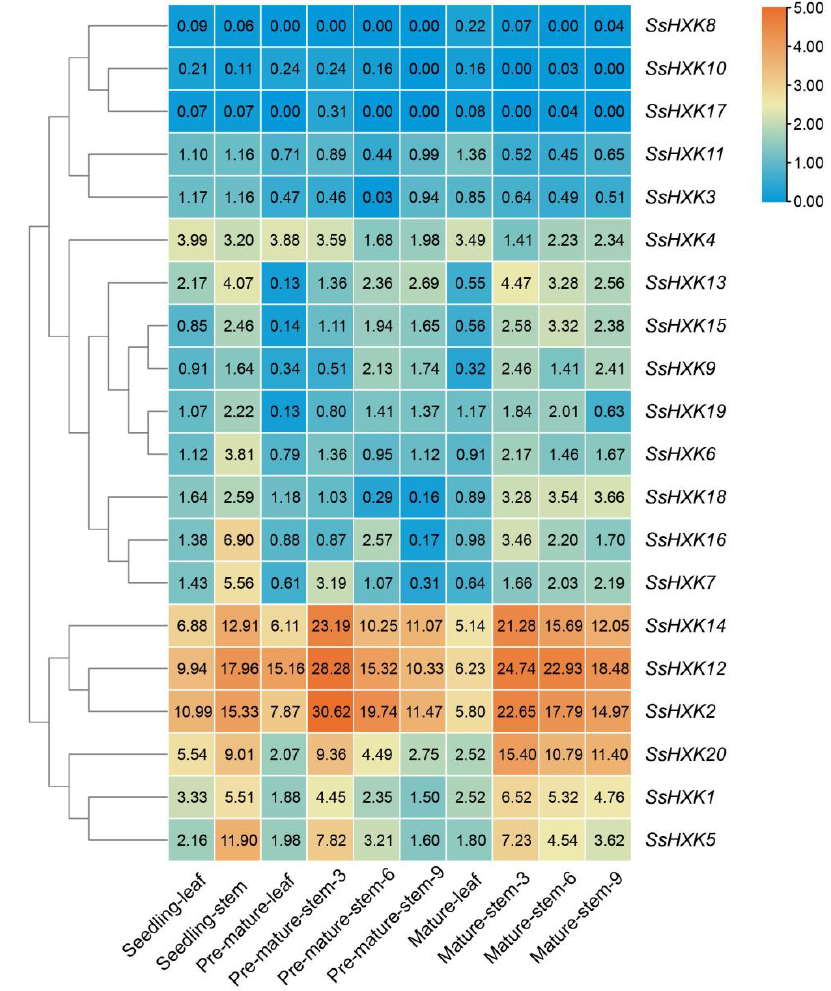
Figure 7. Expression profiles of the HXK genes from S. spontaneum at different development stages. The number in the box represent the origin FPKM values. Seedling, Pre-mature and Mature repre- sented 35-day-old, 9-month-old and 12-month-old S. spontaneum , respectively. Stem-3, stem-6, stem-9 means the thirdly, sixth and ninth nodal stem of sugarcane from the top to bottom, respectively. The color bar represented the normalized values (log 2 FPKM).